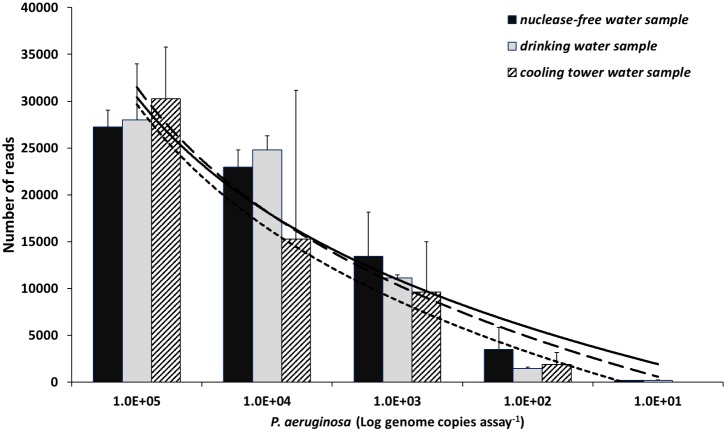
Read abundance relationship with concentration values of P. aeruginosa. Data generated after spike-in of three samples: nuclease-free water (black), drinking water (gray), and cooling tower water (hatched). A logarithmic regression model explains the relationship between the two variables. Solid, dashed, and square-dot logarithmic curve show correlation for nuclease-free water, drinking water, and cooling tower water samples, respectively. The coefficient determination (R2) values were 0.96, 0.94, and 0.92 for the spiked nuclease-free water, drinking water, and cooling tower water samples, correspondingly. Y-axis represents mean number of reads of replicates (n = 3). Data presented as mean + SD. Note the x-axis in log scale.